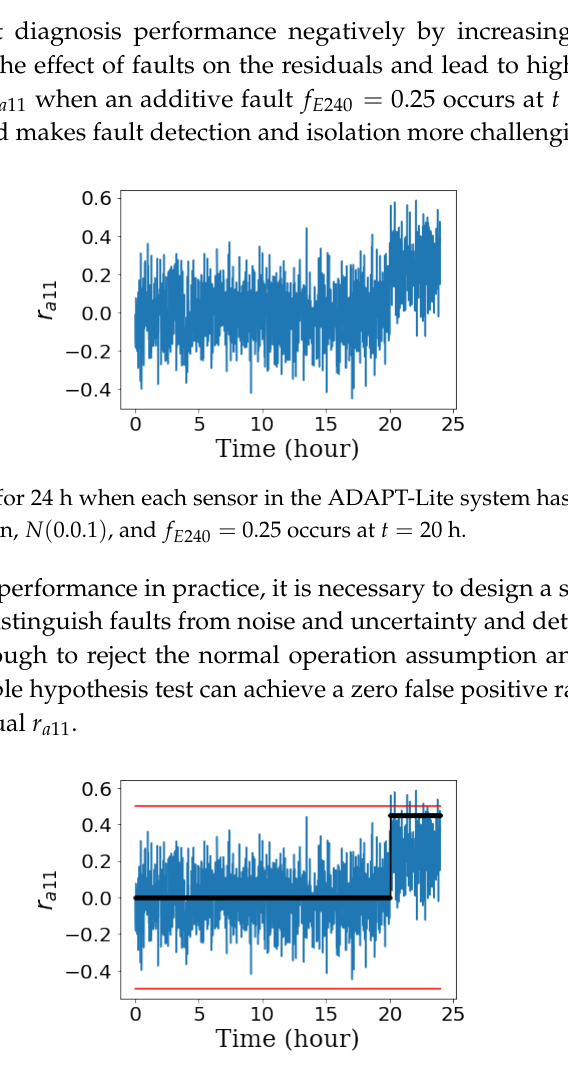
Figure 14. A hypothesis test can achieve a zero false positive rate and detect f E 240 in 4 (cid:48) :48 (cid:48)(cid:48) using residual r a 11 . The step function represents the detection